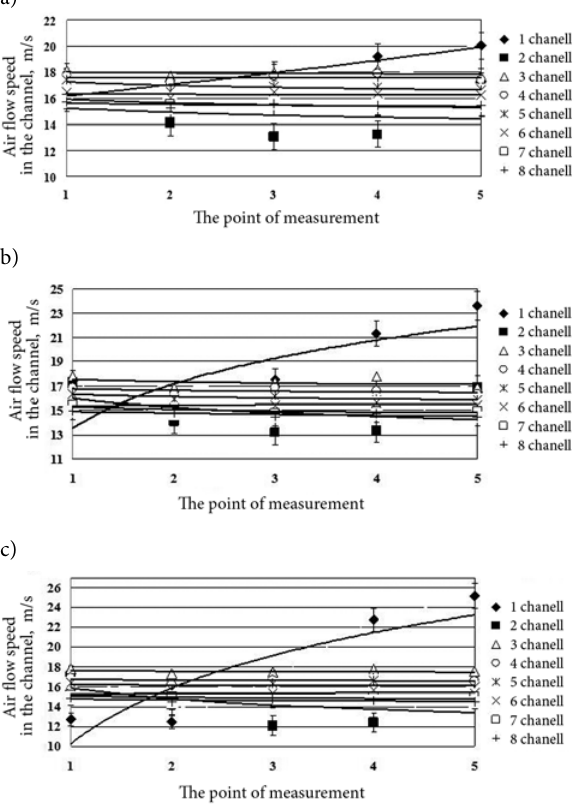
Fig. 4. Distribution of airflow velocities in 8-channel